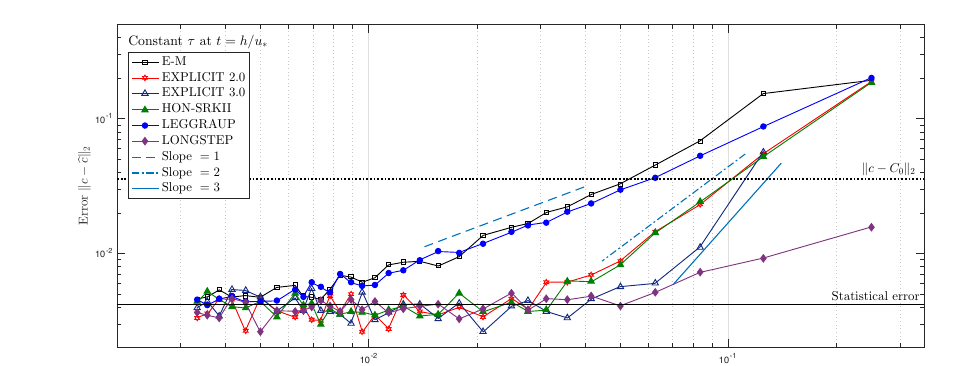
Figure 4. L 2 error (Eq. 20) as a function of non-dimensional time step (cid:49)t u ∗ /h for the constant τ = 0 . 1 test case with N = 10 6 ensemble integrated at time t = h/u ∗ . The LONGSTEP scheme (purple diamonds) gives the best results in this case. Blue lines of slopes 1 , 2, and 3 are plotted for